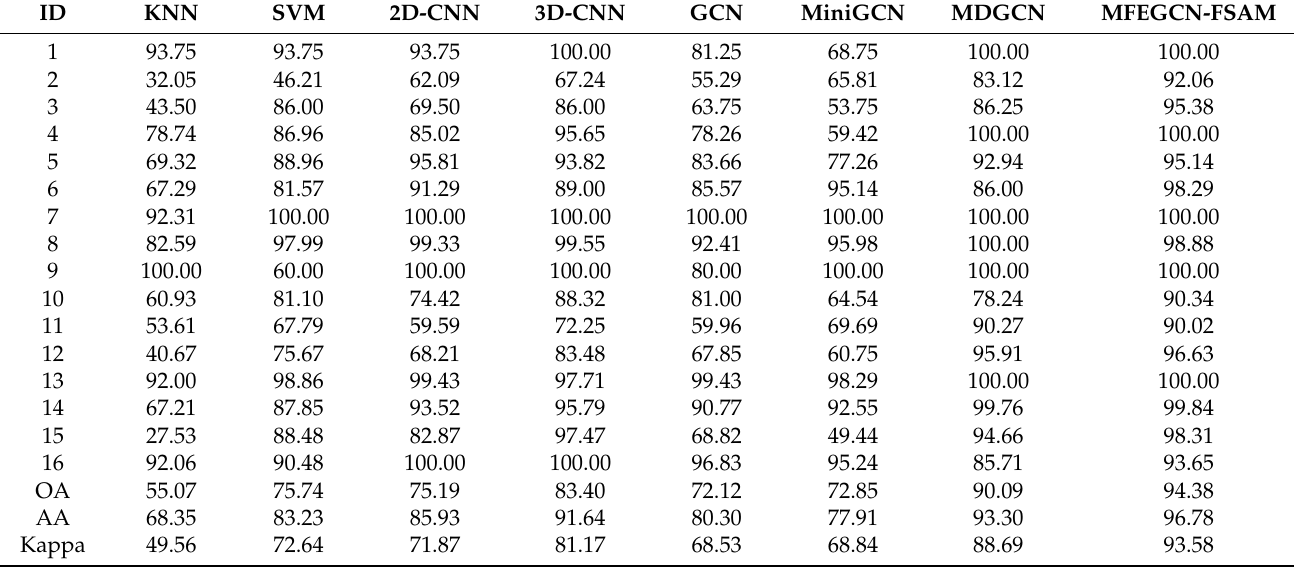
Table 5. Classification performance of different methods on Indian Pines dataset